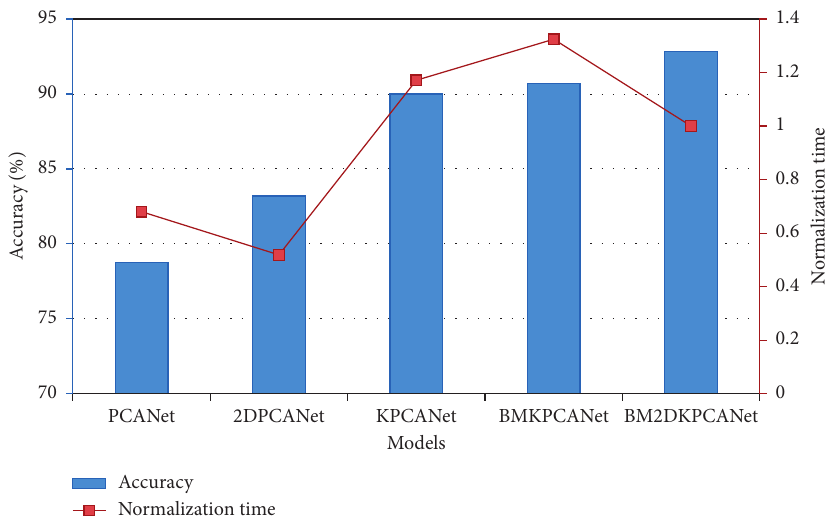
Figure 12: Comparison of model performance on the fruits boxes